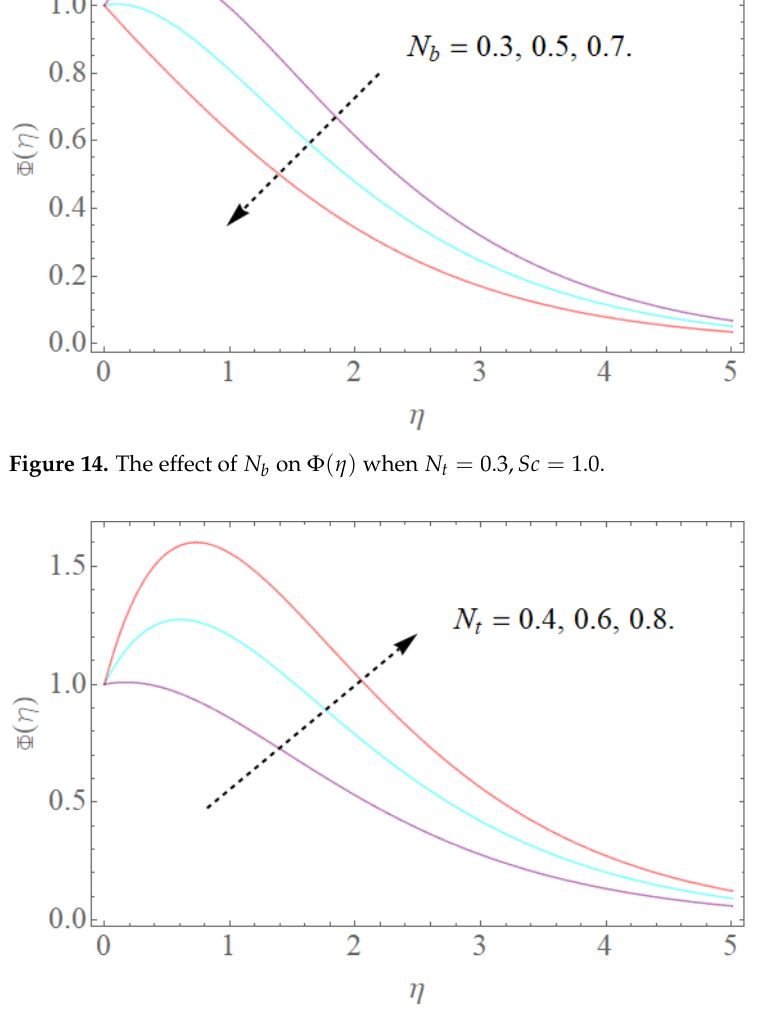
Figure 15. The impact of N t on Φ ( η ) when N b = 0.3, Sc =